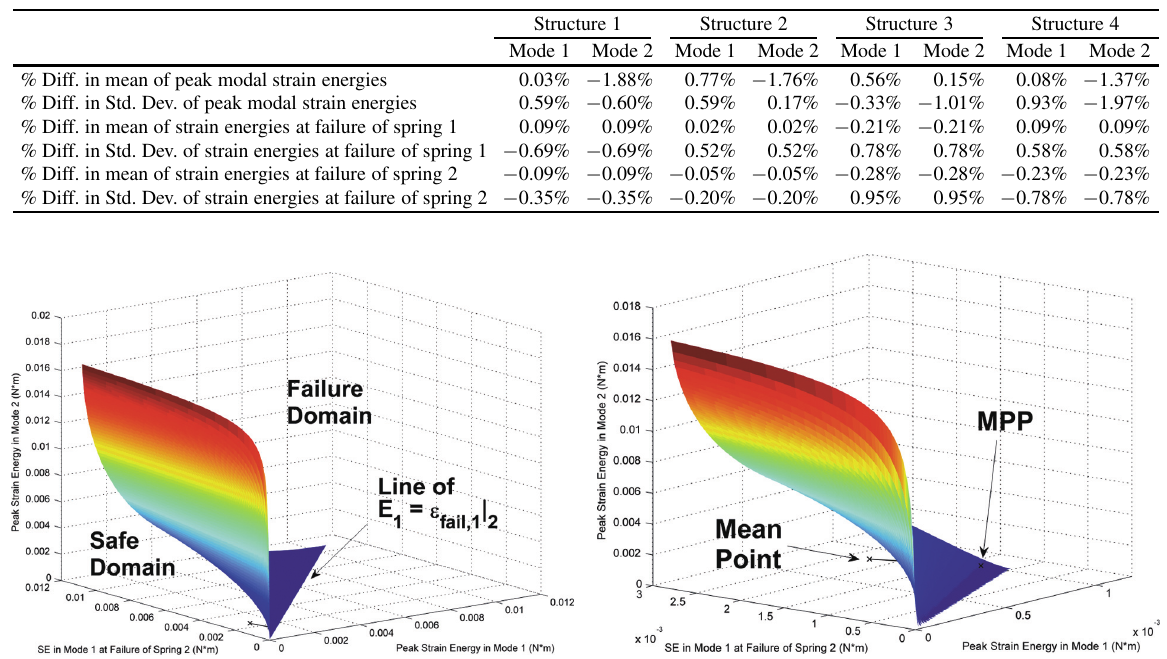
Table 4 Percentage difference between nominal values and actual values from Monte Carlo analysis for mean and standard deviation of peak modal strain